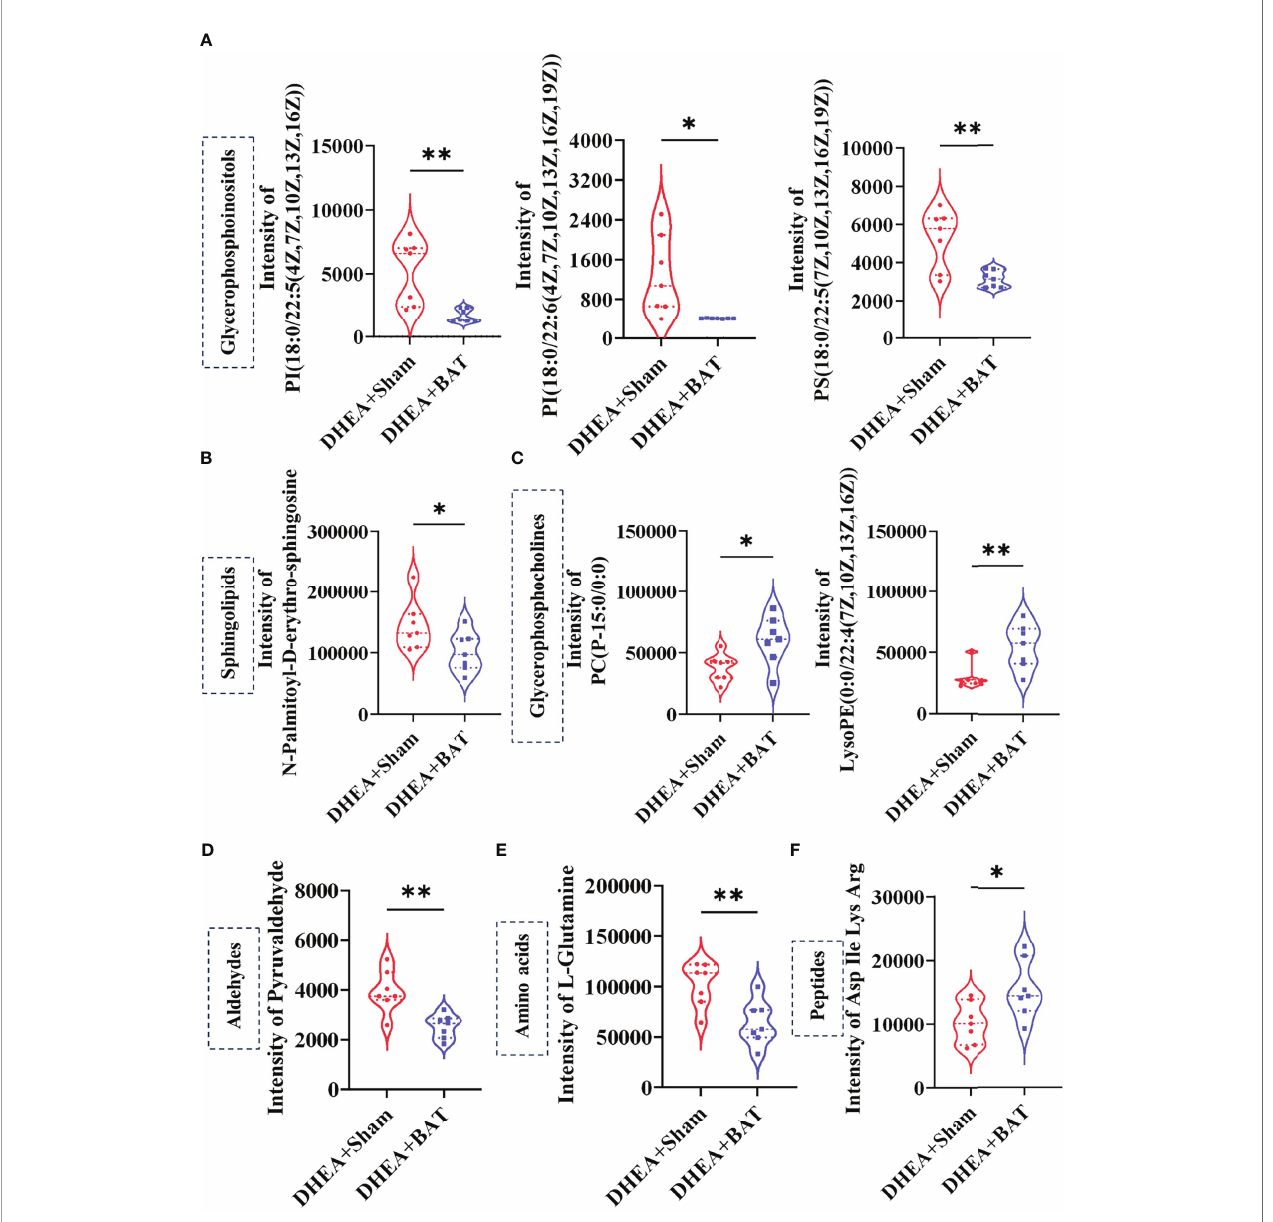
FIGURE 7 | Selected differentially expressed metabolites. (A – C) The glycerophosphoinositols and sphingolipids were decreased, while glycerophosphocholines were increased in the DHEA+BAT group. (D, E) Aldehydes and amino acids were reduced in the DHEA+BAT group compared with that in the DHEA+Sham group. (F) Peptides were increased in the DHEA+BAT group. Data were analyzed using unpaired Student ’ s t -test. * p < 0.05, ** p <